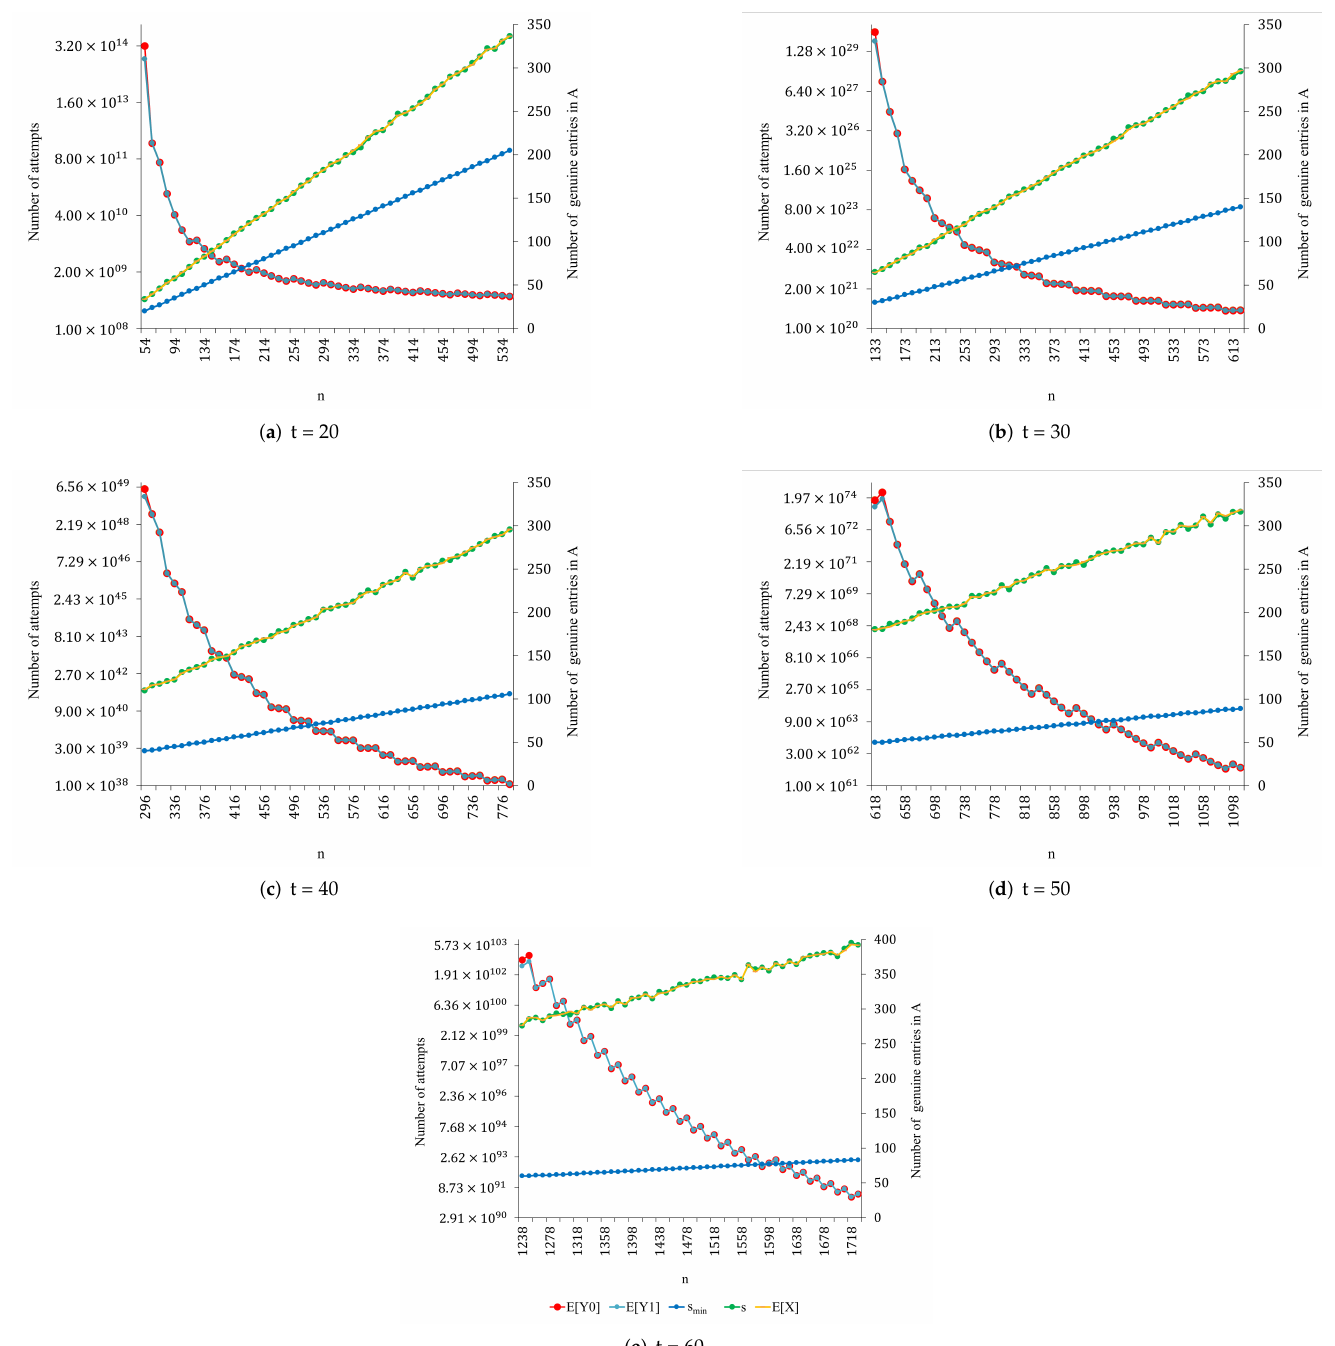
Figure 4. Results obtained for p min = 0.95 ∈ P , t ∈ T , and proper values of n